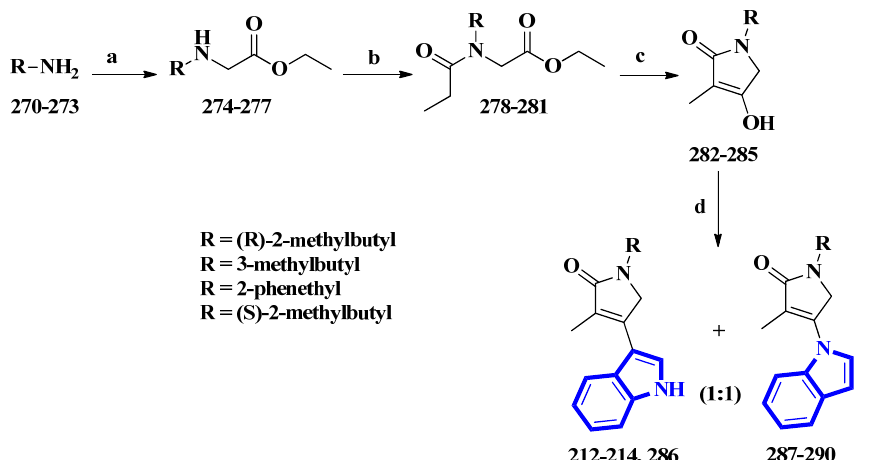
Figure 17. The total synthesis of psammocindoles (A–D) 212–214 , 286 , and their isomers 287–290 . (a) Ethyl bromoacetate, DCM, Et 3 N, rt, 2 h, 90–93%; (b) Propionyl chloride, Et 3 N, 0 °C to rt, 1.5 h, 94–95%; (c) NaH, THF, reflux, 12 h, 83–86%; (d) Indole, BF 3 -Et 2 O, 4 Å MS, PhCl, 100 °C, 1.5 h, 27–31%.